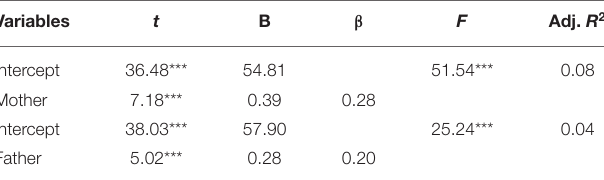
TABLE 7 | Linear regression analysis of perceived parenting of mothers and fathers on narcissism ( N = 628).